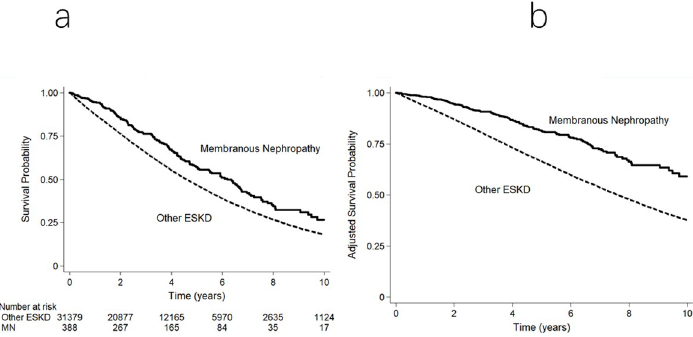
Fig 2. Survival curves for ESKD secondary to membranous nephropathy and other causes in patients commencing dialysis in Australia and New Zealand. (a) Unadjusted Kaplan–Meier survival curve. (b) Survival curve adjusted for demographic and comorbidity indices. The difference between the 2 groups was significant (unadjusted p < 0.001; adjusted p = 0.002).